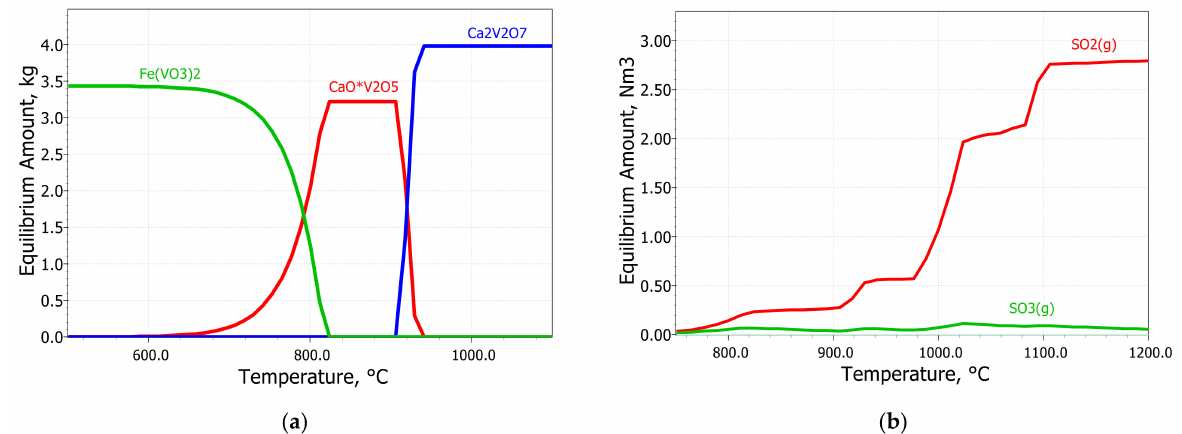
Figure 4. Effect of roasting temperature on the equilibrium amount of vanadium-containing compounds in the solid phase ( a ) and sulphur-containing compounds in the gas phase ( b